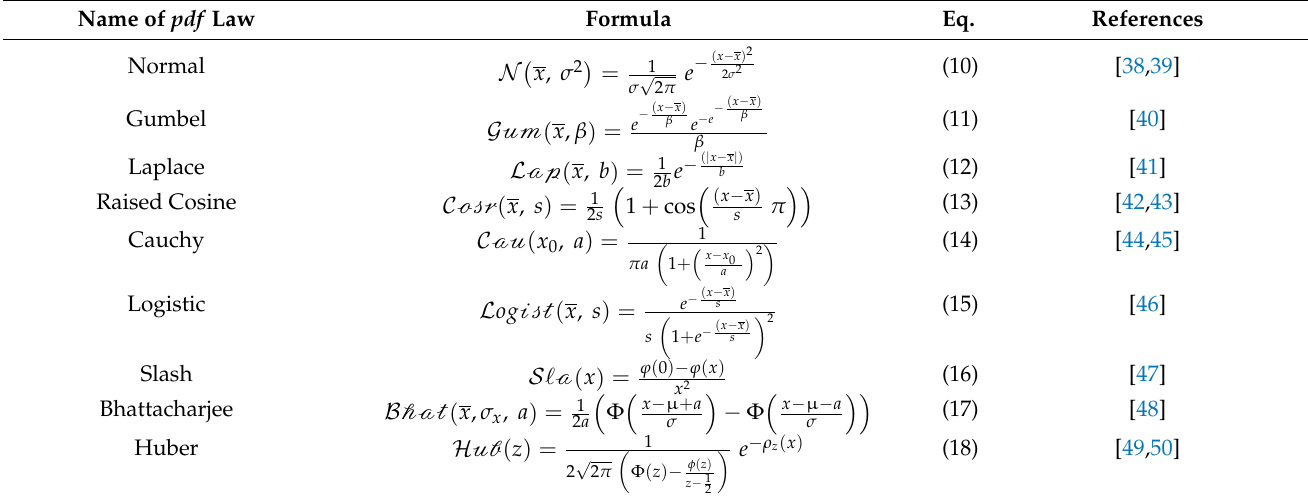
Table 3. Equations of nine probability density